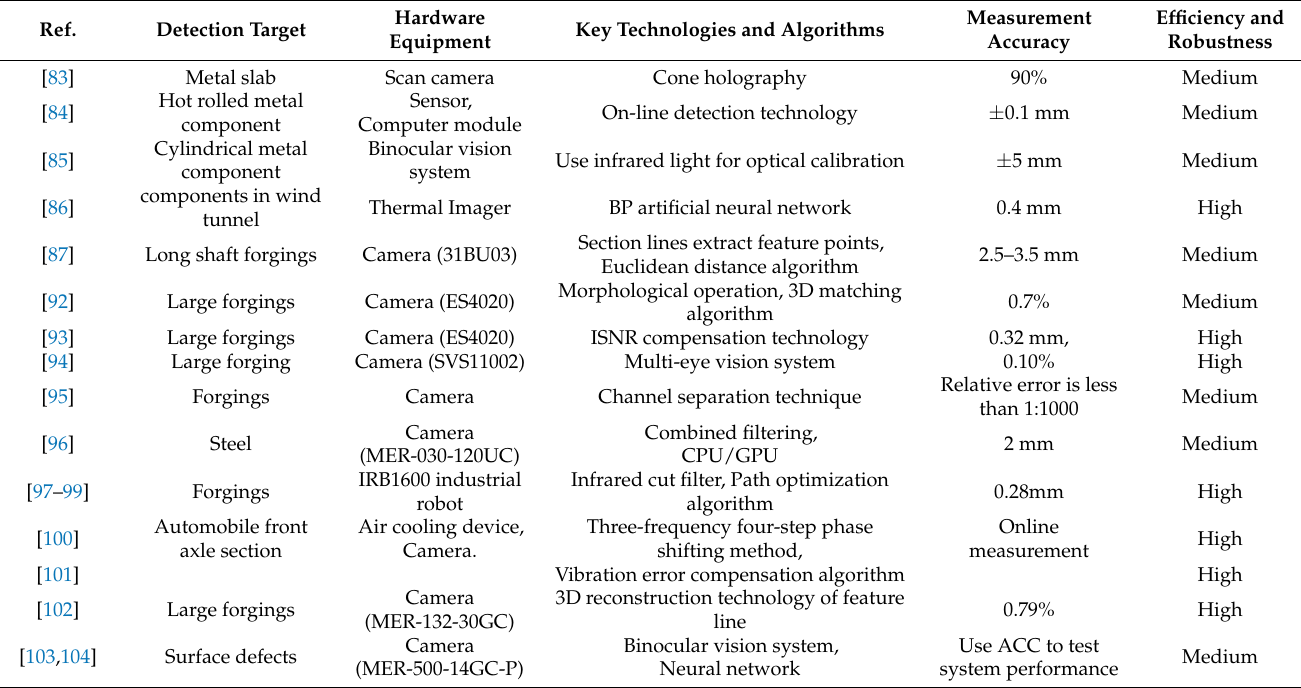
Table 8. Application and comparison of multi-view stereo